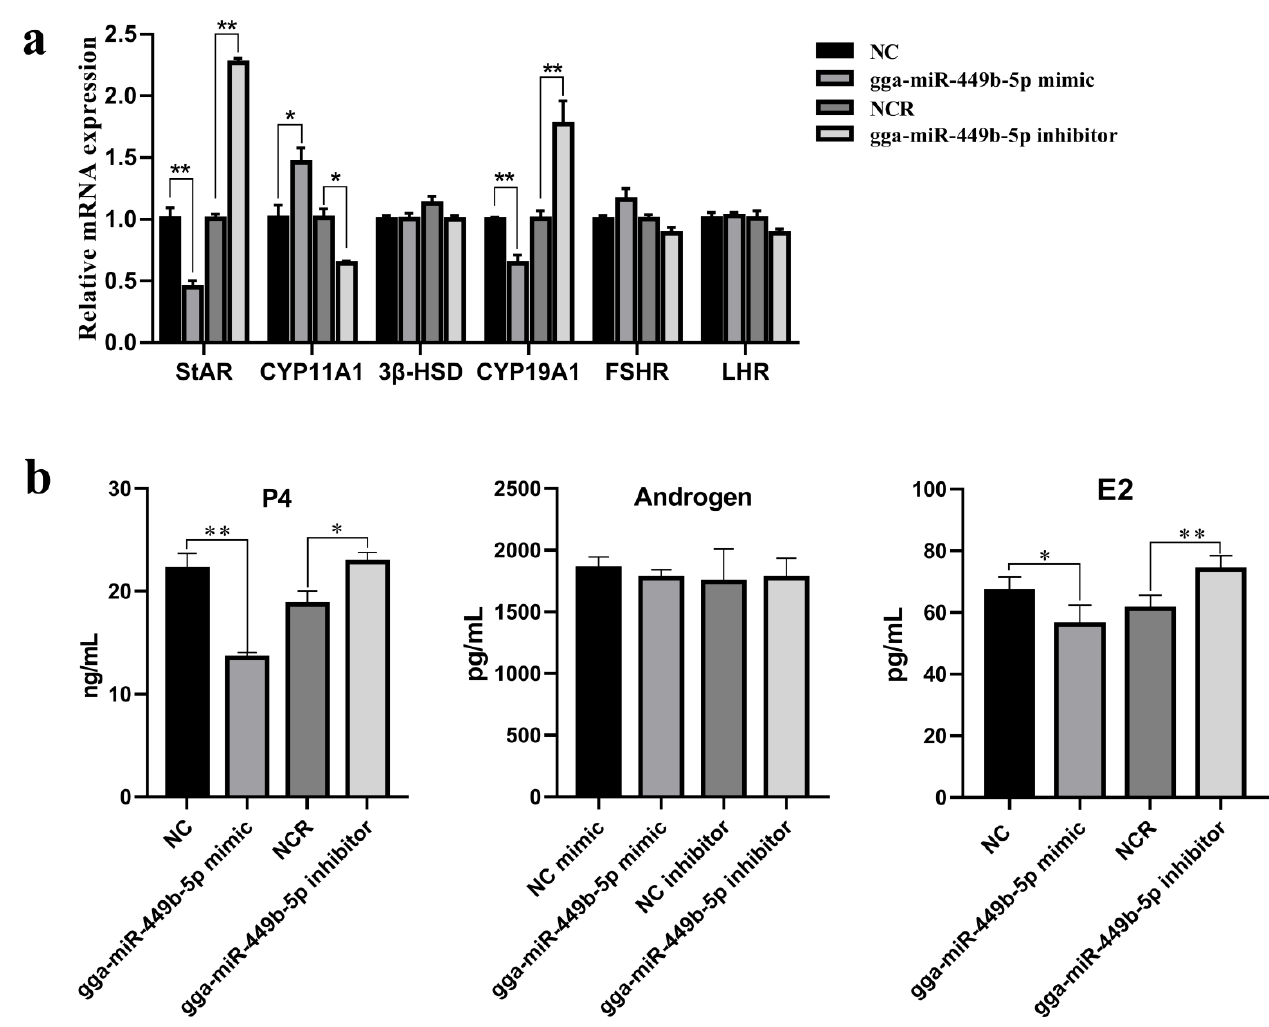
Figure 3. gga-miR-449b-5p regulates steroid secretion from GCs of small yellow follicles (6 – 8 mm). ( a ) The mRNA expression of key genes related to steroid synthesis in GCs after transfection with gga-miR-449b-5p mimics or inhibitor. ( b ) The concentrations of steroid hormones in GCs after transfection with gga-miR-449b-5p mimics or inhibitor. ** and * indicated that there were significant differences ( p < 0.01) and significant differences ( p < 0.05), respectively.